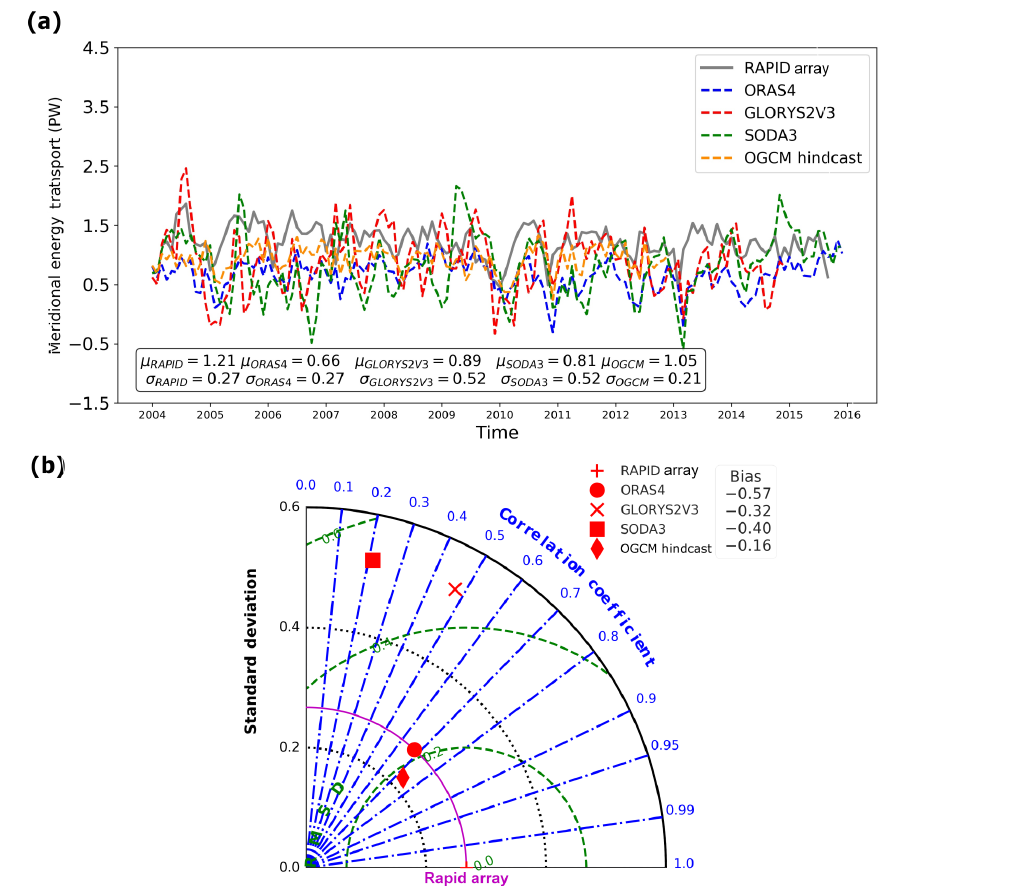
Figure 6. OMET estimated from ORAS4 (blue), GLORYS2V3 (red), SODA3 (green) and the OGCM hindcast (orange) compared to the RAPID array observation (gray) at 26.5 ◦ N across the Atlantic basin. The time series of OMET is presented in panel (a) . The statistical properties are shown in (b) the Taylor diagram, including bias, correlation (blue), standard deviation (black) and root mean square deviation (green). σ is the standard deviation and µ is the mean of the entire time